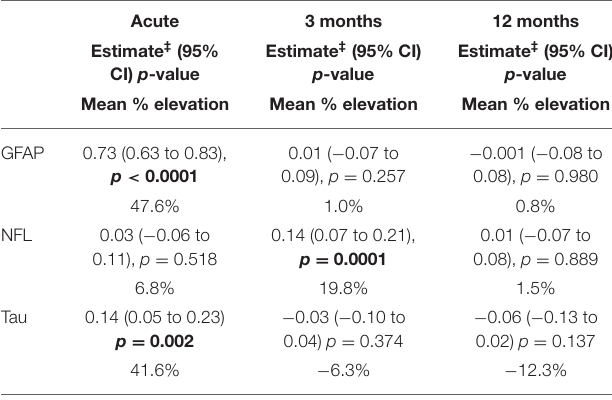
TABLE 4 | Group comparisons of biomarker concentrations between patients with mTBI without somatic injuries (mTBI–) and community controls, at acute, 3 and 12 months, calculated using contrast analyses based on the linear mixed model results.